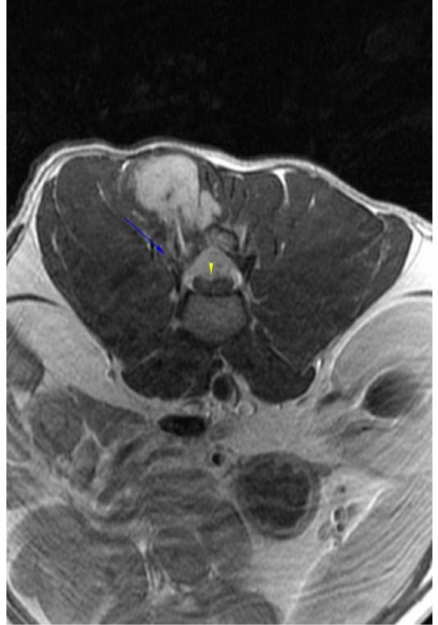
Figure 4. Post-contrast transverse T1W image showing the lysis of the right articular processes of L2/3 (blue arrow), expansion of the mass in the vertebral canal, and severe flattening of the spinal cord (yellow